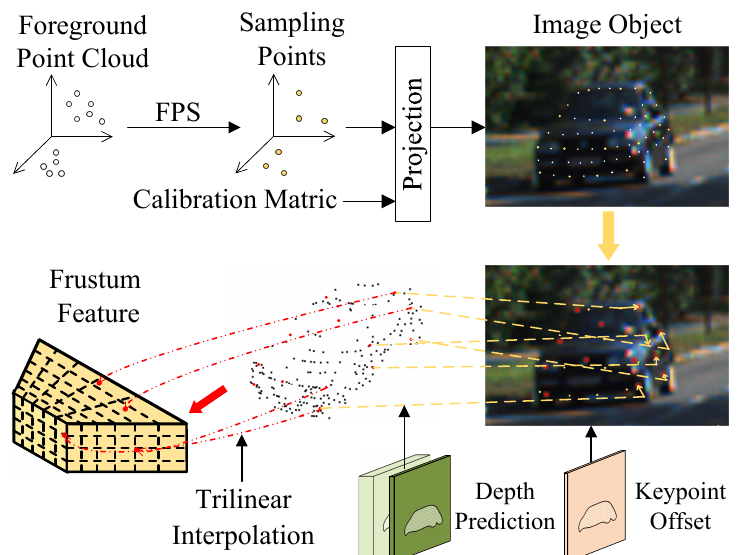
Figure 4. Illustration of Frustum-to-point Transition module. The white point is the foreground point, yellow is sampled foreground point, and red is the keypoint of the